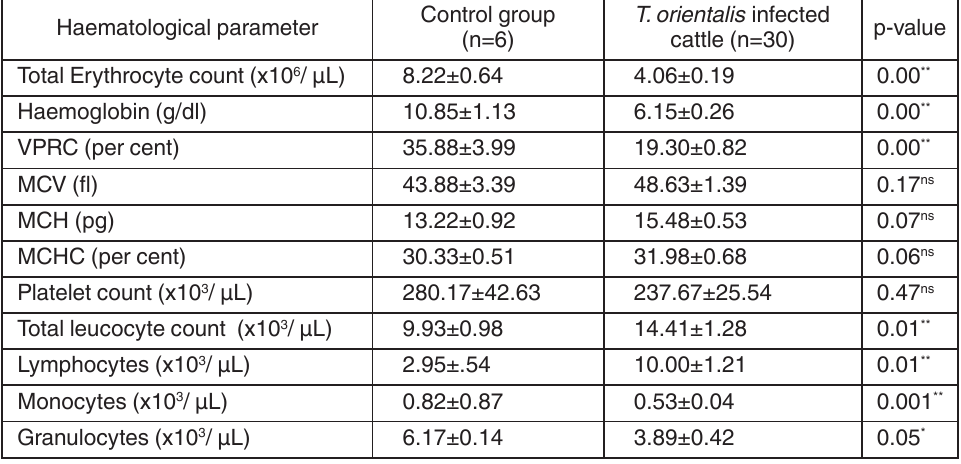
table 1. Haematological parameters in control group and T. orientalis infected cattle Haematological parameter